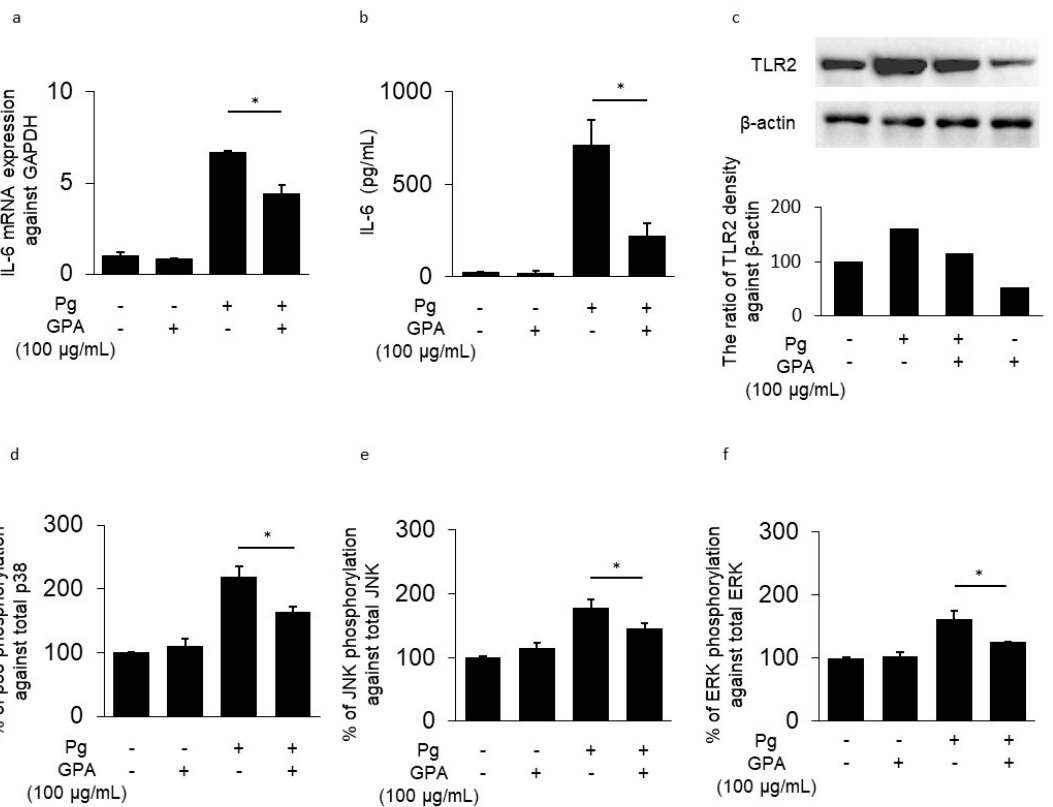
Figure 1. Inhibitory effects of geniposidic acid (GPA) on human gingival epithelial cells (HGECs) ( a ) mRNA expression of IL-6 in HGECs with or without Porphyromonas gingivalis stimulation (12 h) in the presence or absence of GPA (100 µ g/mL). ( b ) Levels of IL-6 in the supernatant of HGECs with or without P. gingivalis stimulation (24 h) in the presence or absence of GPA (100 µ g/mL). ( c ) Production of TLR2 in HGECs with or without P. gingivalis stimulation (12 h) in the presence or absence of GPA (100 µ g/mL). ( d – f ) Levels of phosphorylated protein in HGECs with or without P. gingivalis stimulation (10 min) in the presence or absence of GPA (100 µ g/mL, ( d ): p38, ( e ): JNK, f: ERK). Results are shown as the mean ± SD. * Significantly higher expression by Student’s t -test (* p <